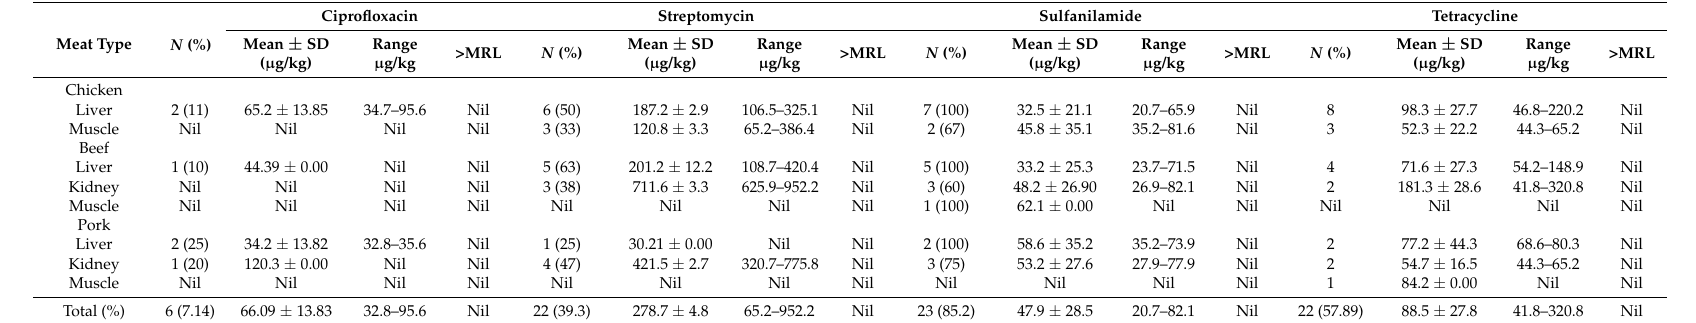
Table 5. Quantification of antibiotic residues in meat samples with